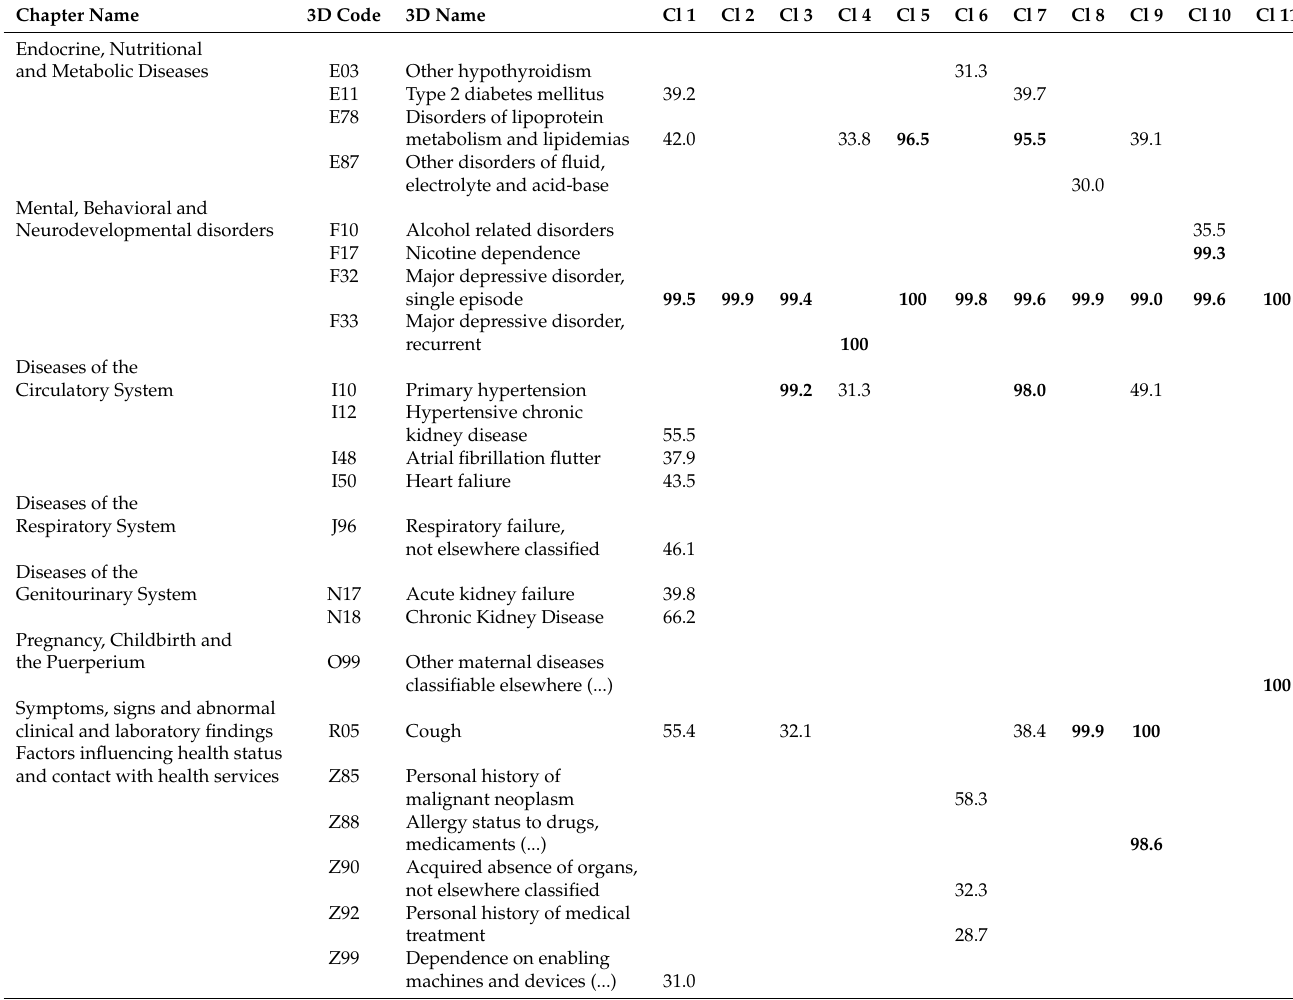
Table 1. Percentage of diagnoses coded in ICD-10 with 25% or more appearance in each cluster. The first column (Chapter name) indicates the icd10 chapter in which the corresponding diagnosis is